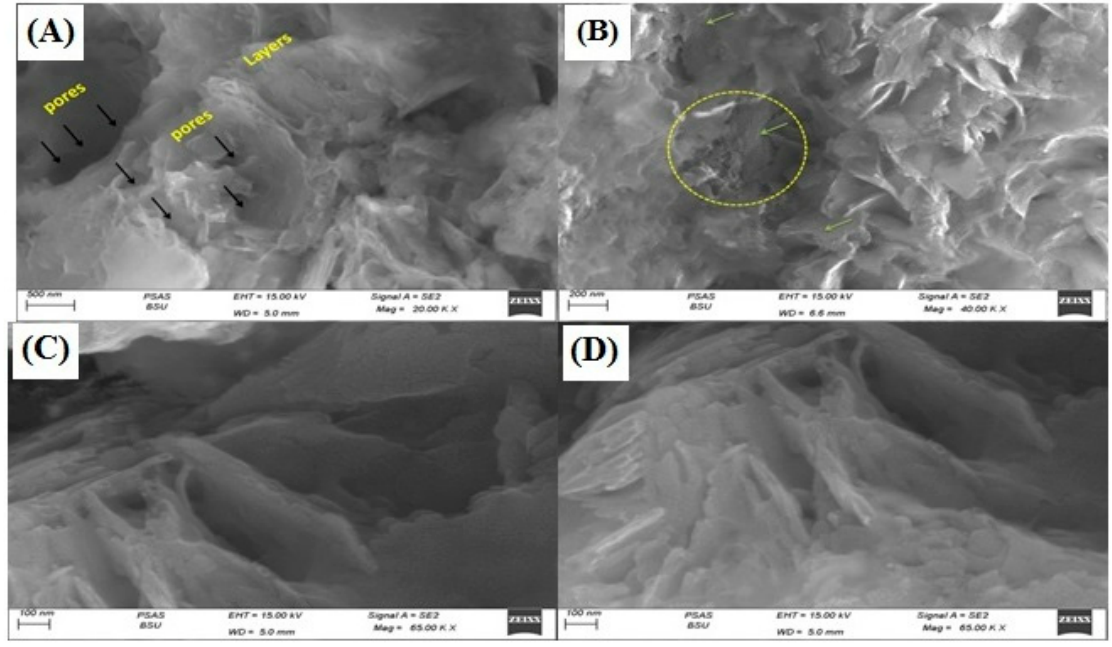
Figure 3. SEM images of prepared Nano ZT/Vit B12 ( A – D ).